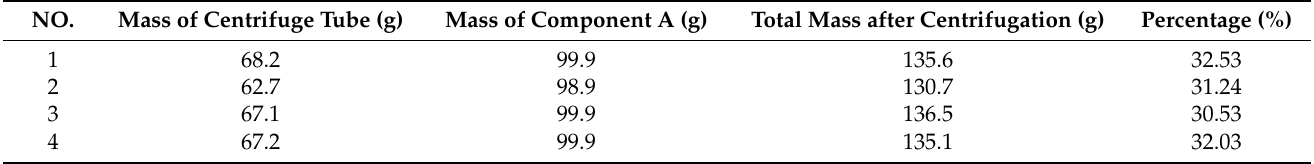
Table 2. Percentage of yellow liquid mass in component